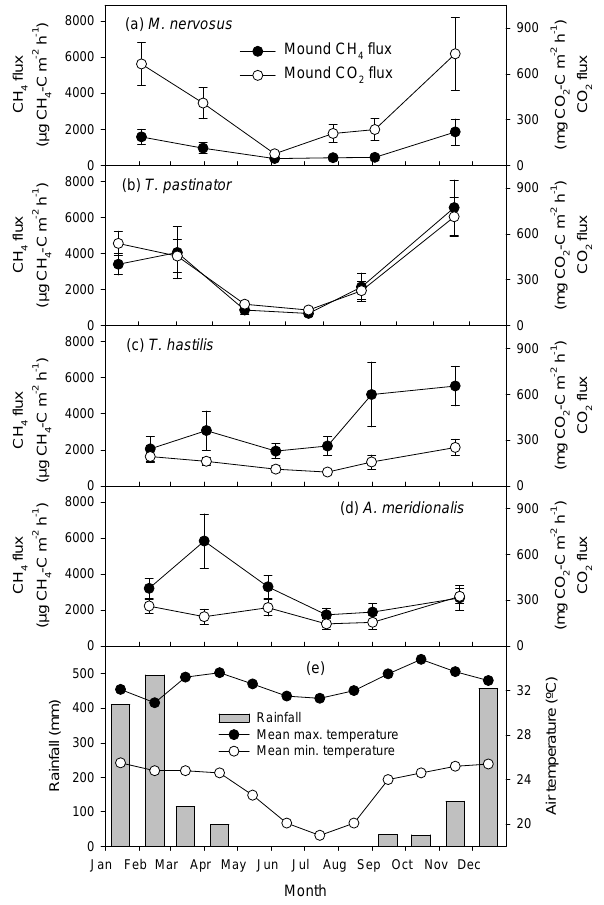
Fig. 1. Mean fluxes of CH 4 and CO 2 repeat-measured from mounds ( n = 5–7) of four termite species at four different savanna sites; error bars are standard error of the mean; panel (e) shows 2009 monthly climate data for Darwin Airport (Bureau of Meteorology, Australia).